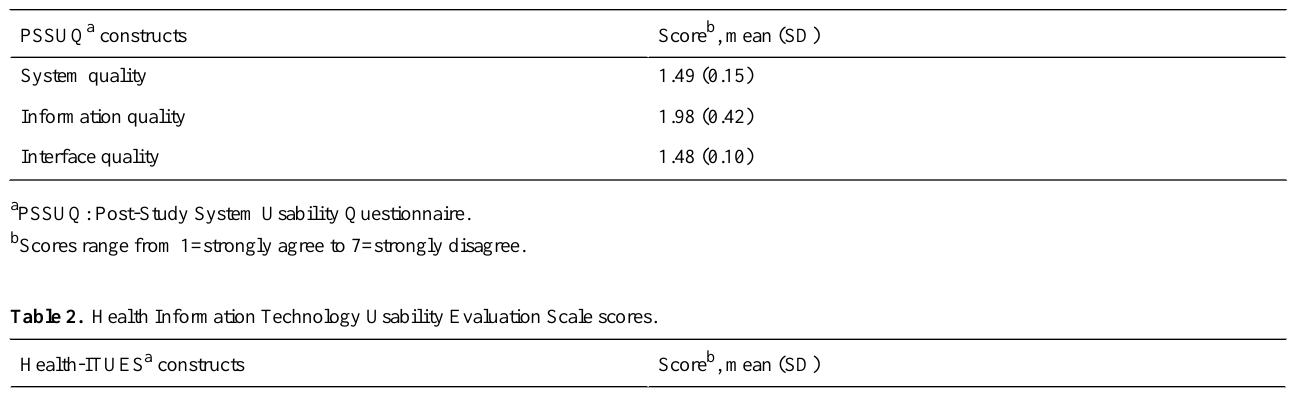
Table 1. Post-Study System Usability Questionnaire scores (N=20).